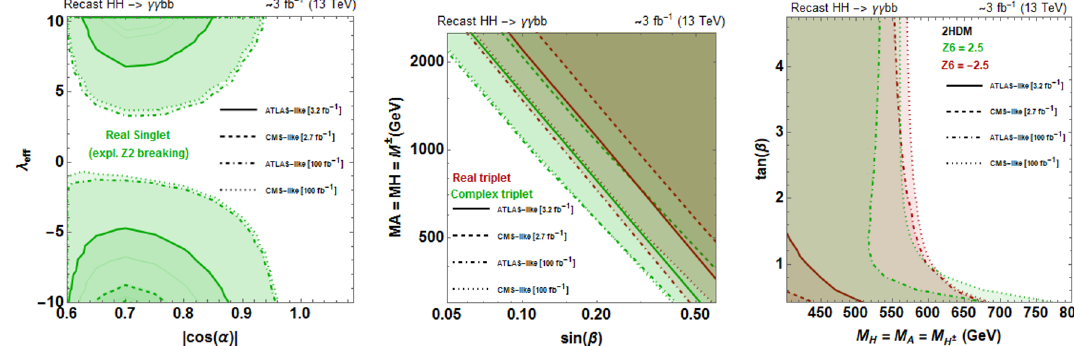
Figure 6 . ATLAS (continuous lines) and CMS (dashed lines) 95% exclusion bounds (as well as projected constraints) for different explicit models given in table 5, as derived in the EFT